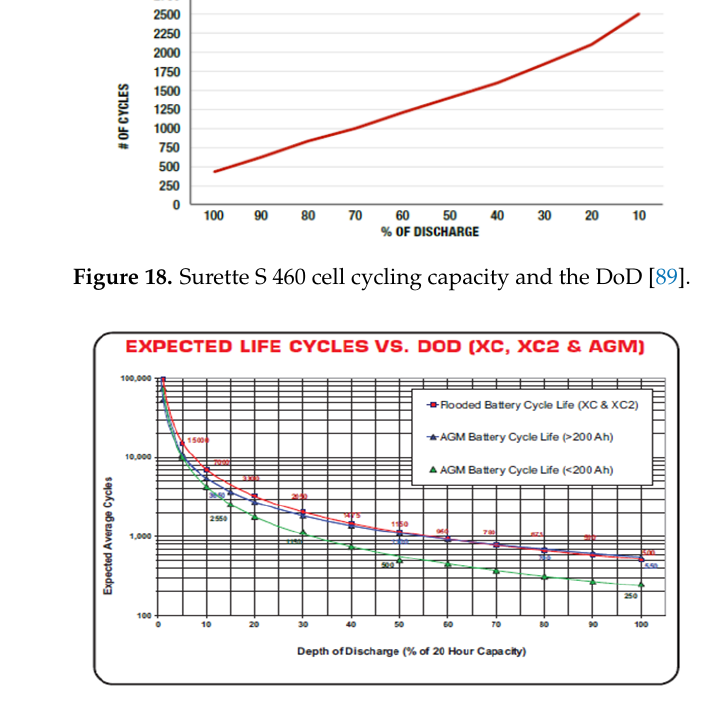
Figure 19. USB US-305 cell cycling capacity and the DoD [90].